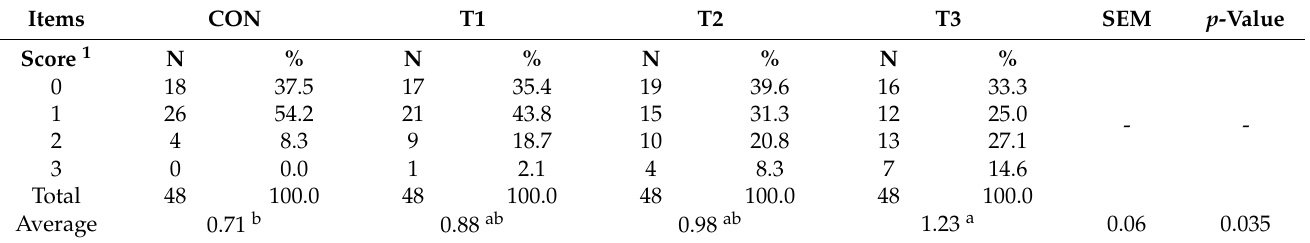
Table 11. Effects of full-fat almonds on the incidence of foot-pad dermatitis in broiler